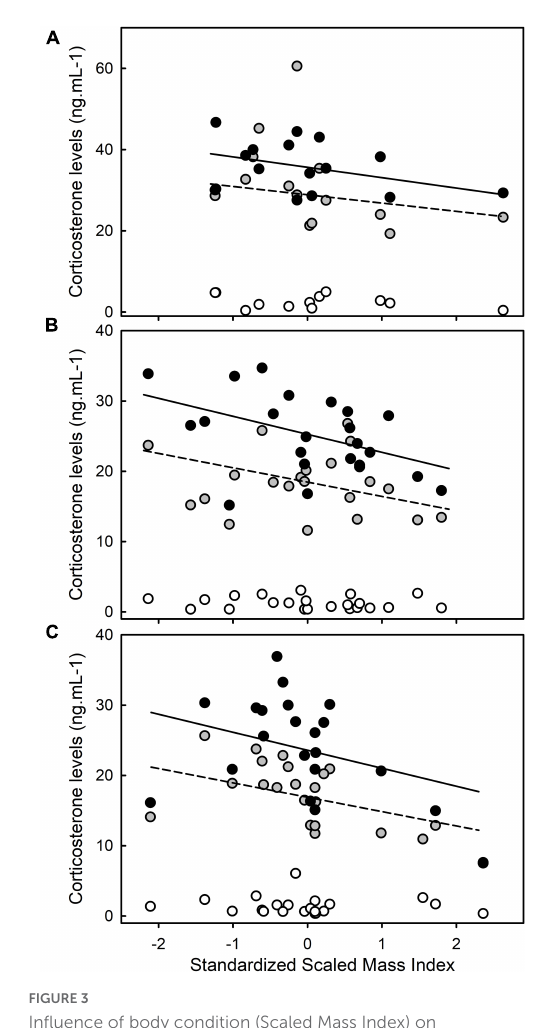
FIGURE3 Influence of body condition (Scaled Mass Index) on corticosterone levels in 11-days old (A) , 20-days old (B) , and 37-days old (C) chicks. White, gray and black dots represent baseline corticosterone levels, stress-induced corticosterone levels after a 15 min restraint, and stress-induced corticosterone levels after a 30 min restraint, respectively. Solid and dashed lines represent significant relationships between body condition and corticosterone levels (dashed: stress-induced corticosterone levels at 15 min; solid: stress-induced corticosterone levels at 30 min).